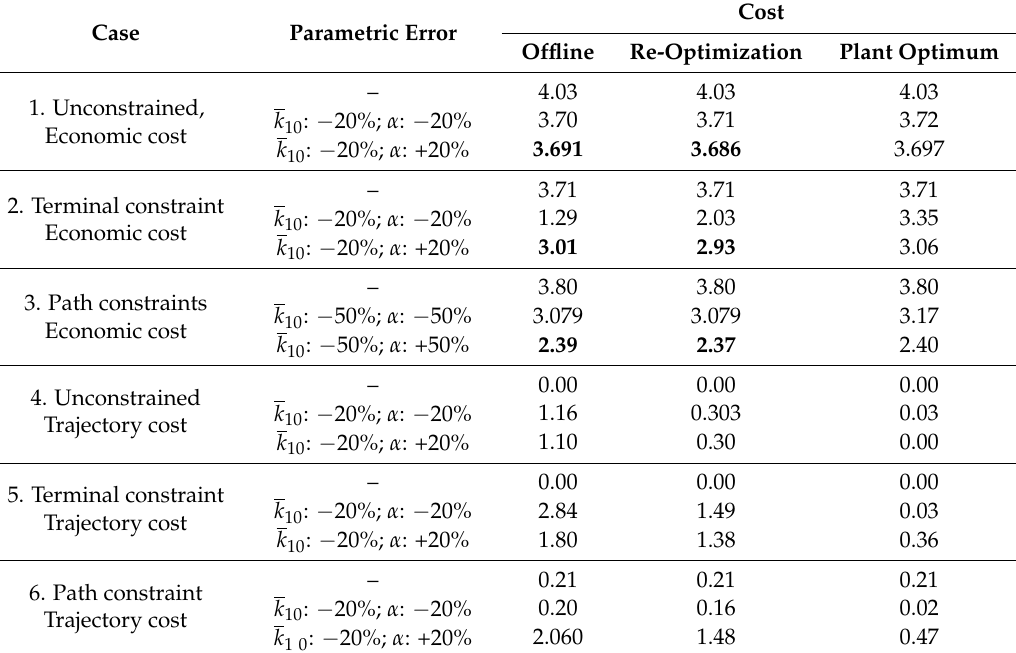
Table 2. Comparison of offline, re-optimization and plant optimum solutions for the six cases with parametric errors. Cost is maximized for Cases 1–3 and minimized for Cases